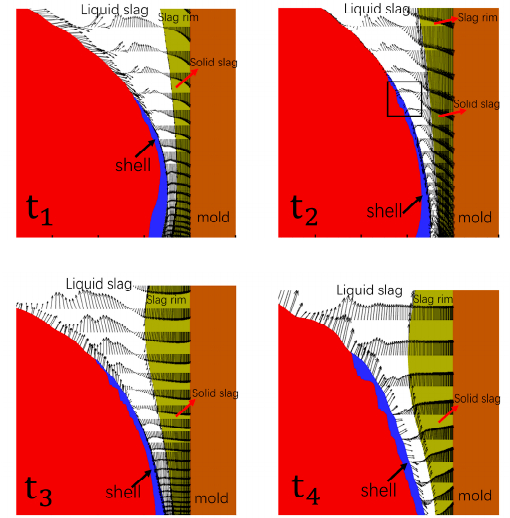
Figure 7. Transient flow behavior of slag during one